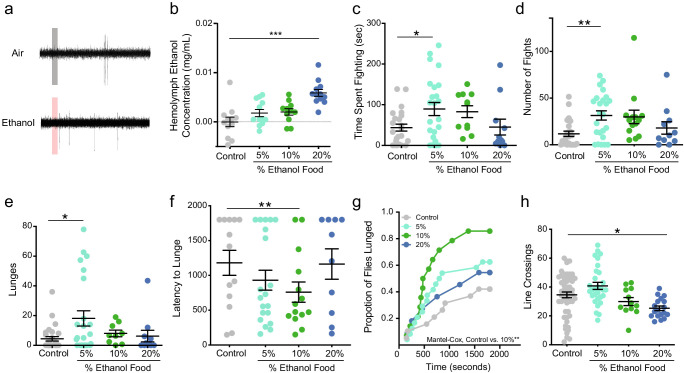
Alcohol odor increases aggression in male flies.(a) Traces of T1 sensilla recordings with a 300 ms exposure to air or vapor from 30% ethanol. (b) Hemolymph ethanol concentration (mg/mL) in flies in aggression arenas for 30 mins show no significant increases except with 20% ethanol (one-way ANOVA with Dunnett’s p<0.0001, n = 11–12). (c) Time spent fighting on ethanol-containing food (Control vs. 5% p=0.038 Kruskal-Wallis test with Dunn’s correction, n = 10–20). (d) Number of fights on ethanol-containing food (Control vs. 5% p=0.0012, statistical tests as in c). (e) Lunges on ethanol-containing food (Control vs. 5% p=0.0225, statistical tests as in c). (f) Latency to lunge (p=0.009, Log-rank Mantel-Cox with Bonferroni correction). (g) Cumulative latency of flies that lunged during the test (Control vs. 10% p=0.009, Log-rank Mantel-Cox with Bonferroni correction). (h) Locomotion as measured by line crossings during the test (Control vs. 20% p=0.0048, statistical tests as in 1 c). p<0.05 *; p<0.01 **; p<0.001 ***. Error bars denote SEM.